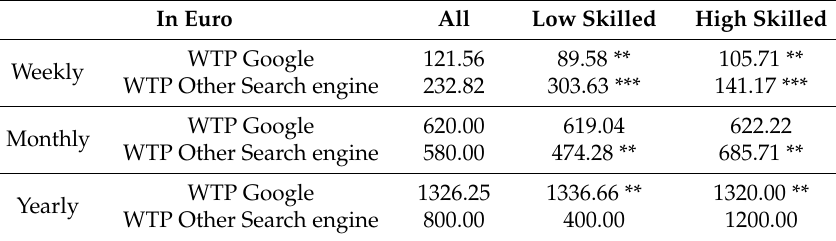
Table 2. Valuations: full sample and low- and